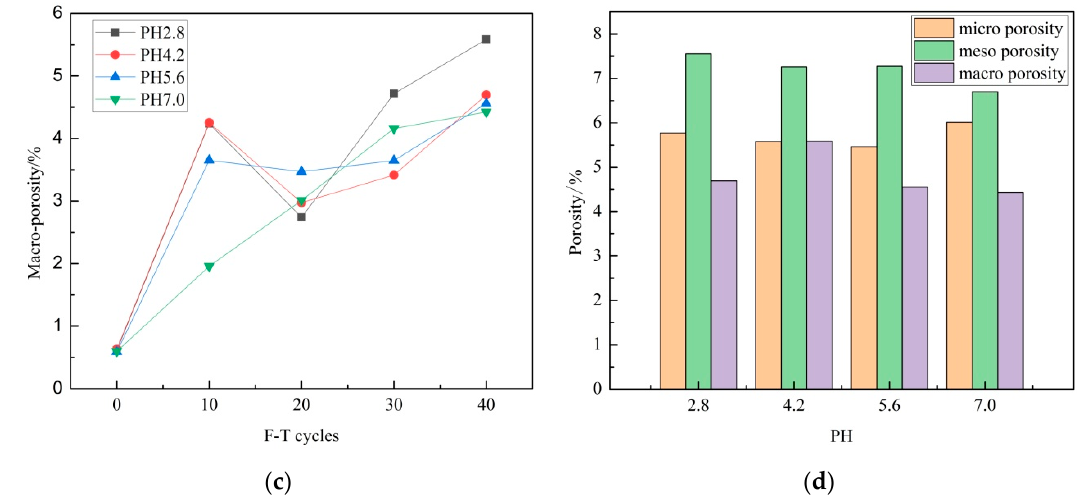
Figure 5. Porosity of sandstone immersed in acid solution after different F–T cycles: ( a ) micro-porosity; ( b ) meso-porosity; ( c ) macro-porosity; ( d ) porosity of samples under 40 F–T cycles in different acidic solutions.